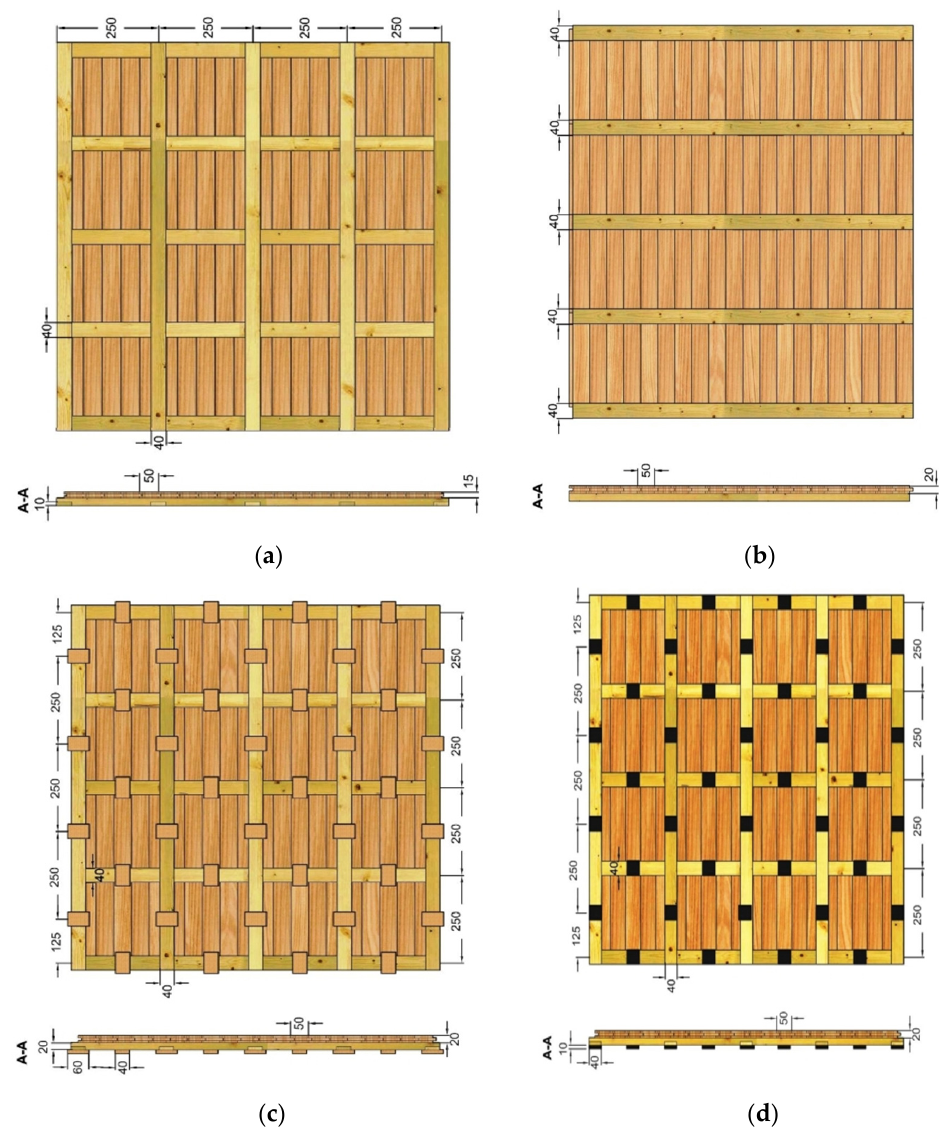
Figure 4. Floor structures (back) for basketball halls (A–A cross-section) ː ( a ) with parallel softwood slats; ( b ) with grid (in the form of a chessboard) made of softwood slats; ( c ) made of softwood slats and beech shock pads; ( d ) made of softwood grid in the form of a frame and rubber shock pads.